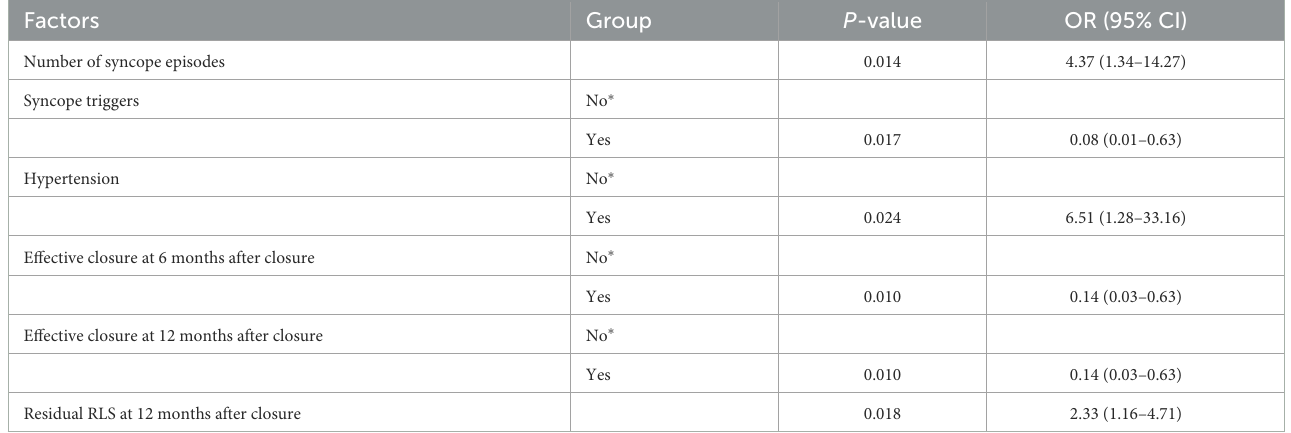
TABLE 5 Factors influencing syncope recurrence after PFO closure (univariate logistic